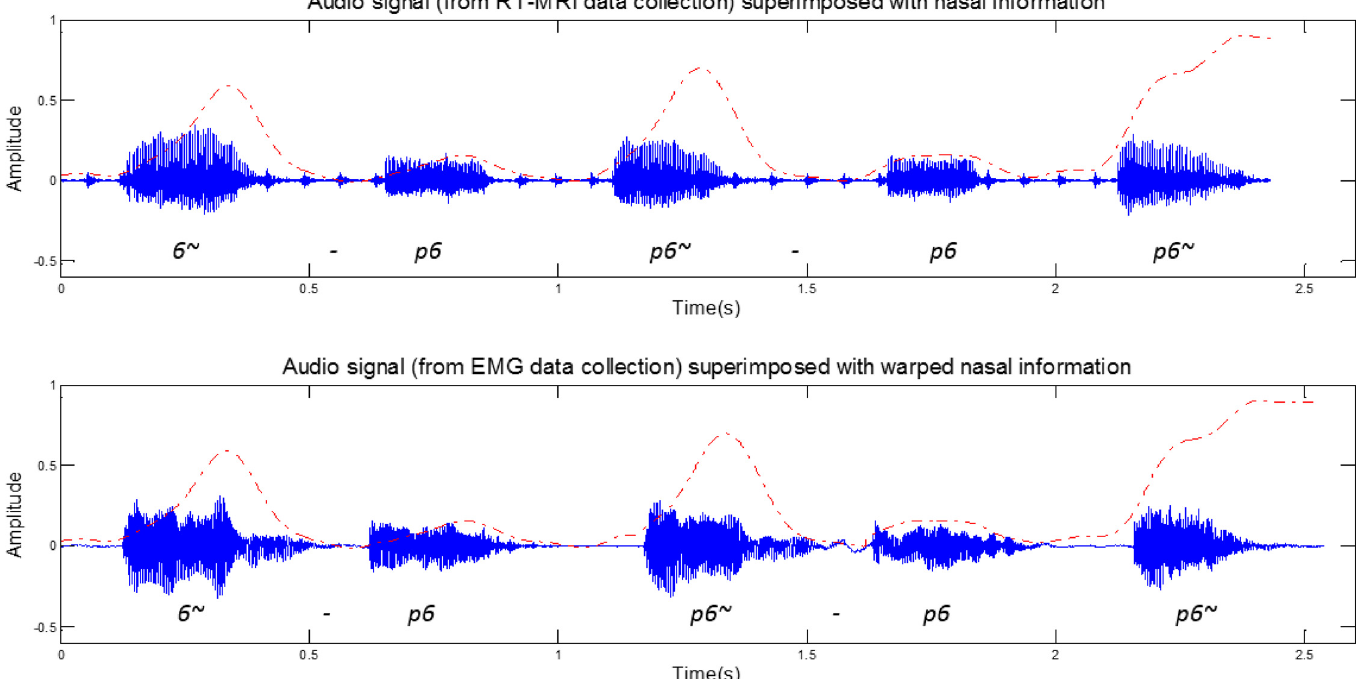
Fig 3. Exemplification of the warped signal representing the nasal information extracted from RT-MRI (dashed line) superimposed on the speech recorded during the corresponding RT-MRI and EMG acquisition, for the sentence [6~p6, p6~p6,